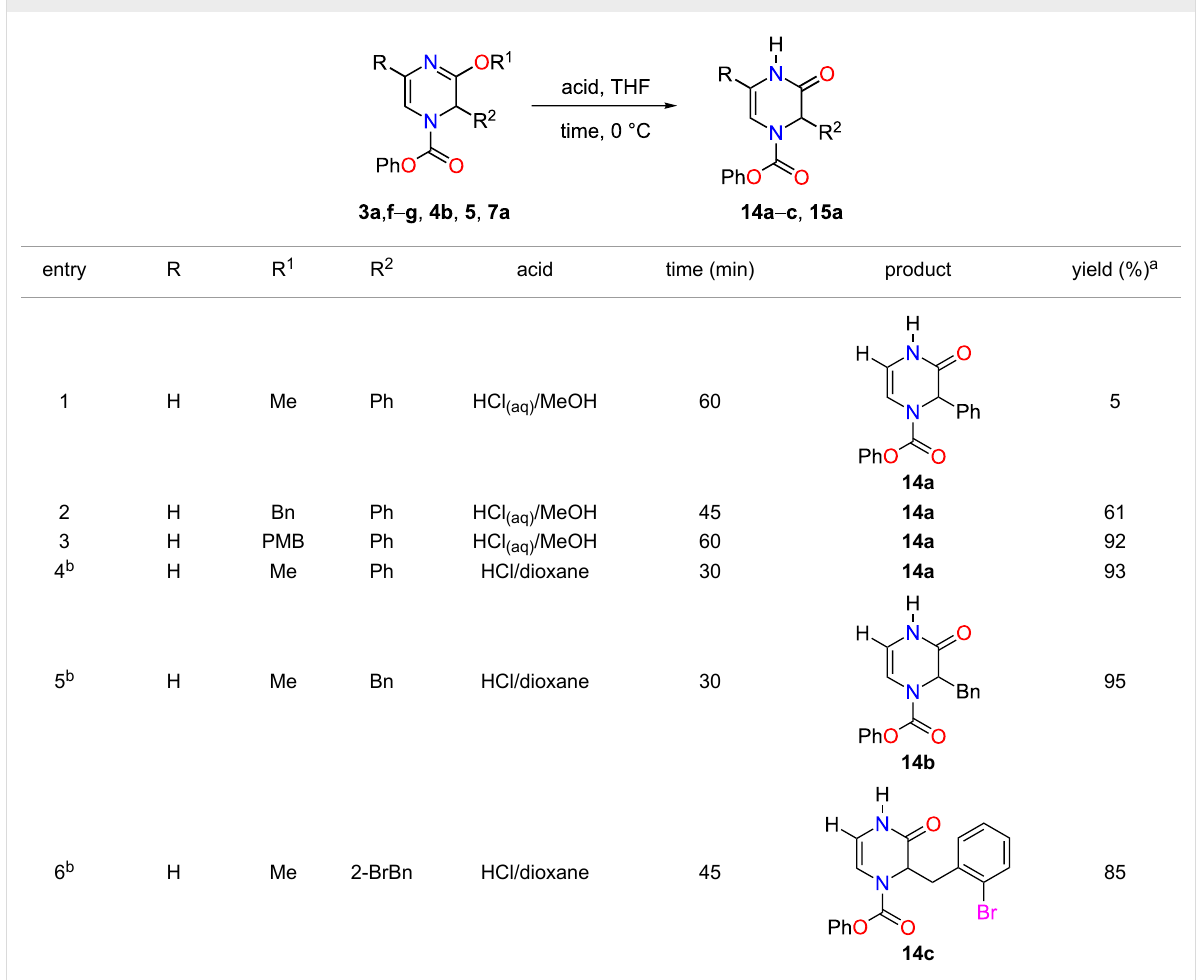
Table 2: Conversion of dihydropyrazine to Δ 5 -2-oxopiperazines under acidic conditions.